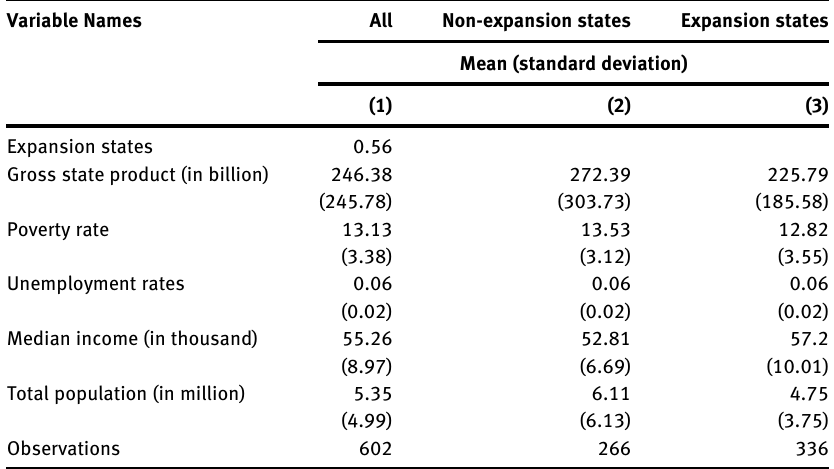
Table  b: Descriptive statistics for control